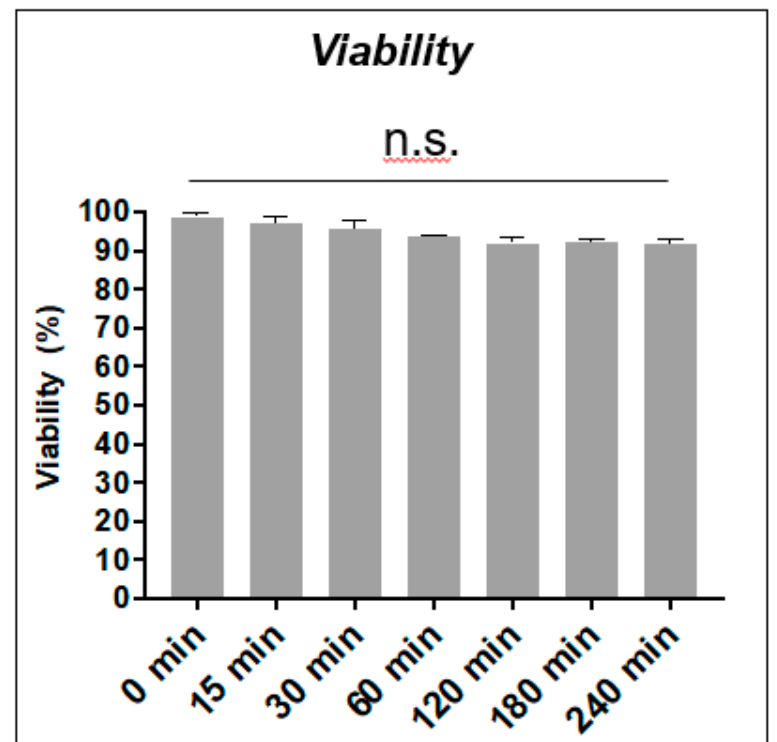
Figure 2. Trypan blue viability assay. Trypan blue assay of isolated T cells at different time points (from 15 min to 240 min) of 0.3 mM diamide oxidation. Viability is expressed as percent of total cell number (%). p value of the viability time points was found to be statistically non-significant (N = 3).